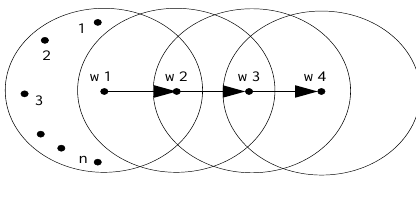
Figure 4. Simulation scenario.